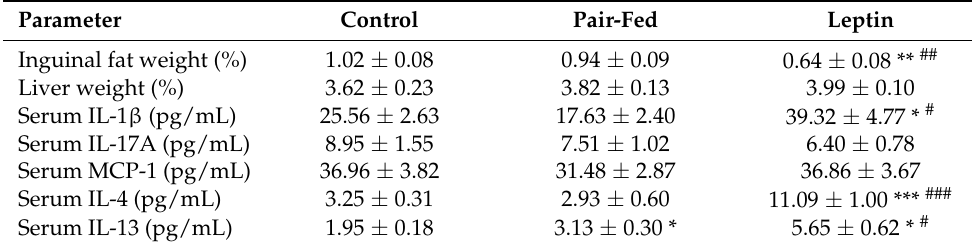
Table 1. Weight of subcutaneous fat and liver and circulating levels of cytokines. Parameter Control Pair-Fed Leptin Inguinal fat weight